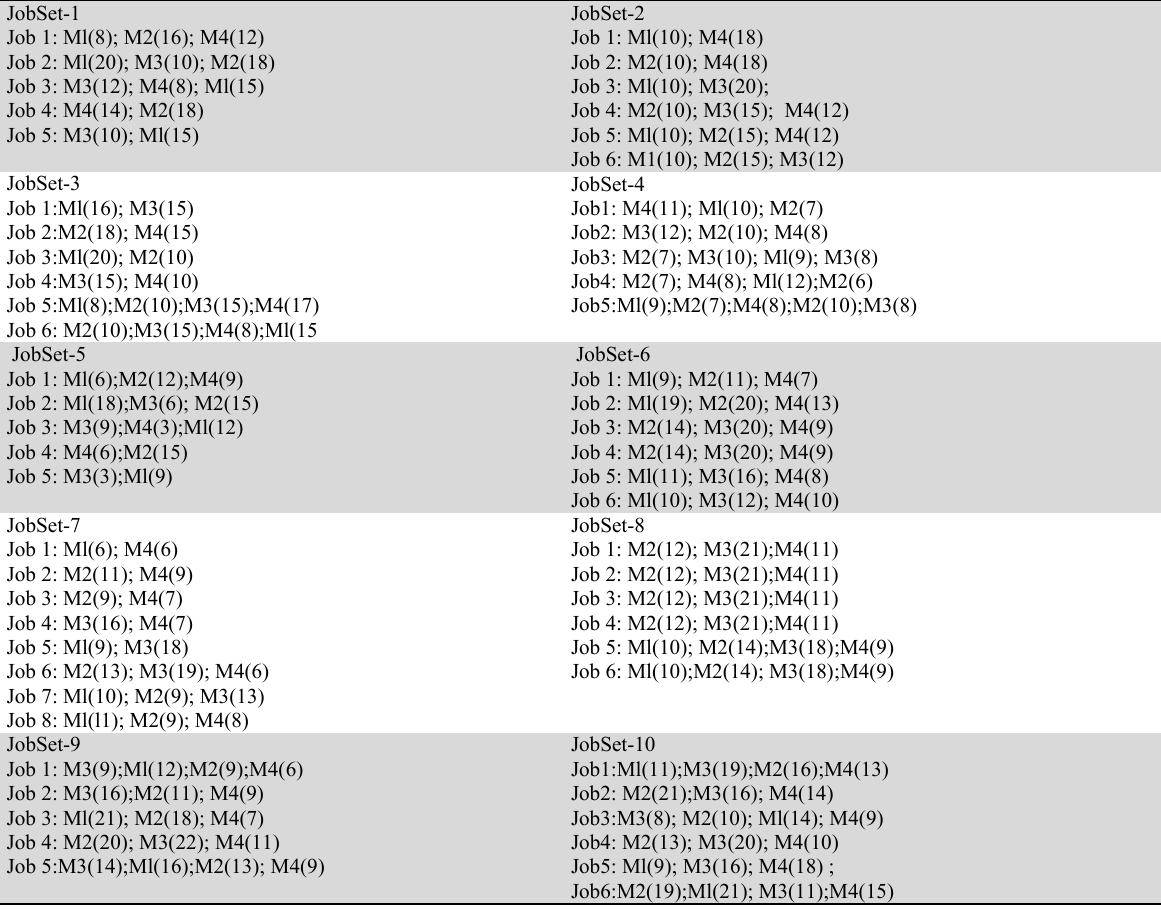
Data for the Job Sets Used in Example